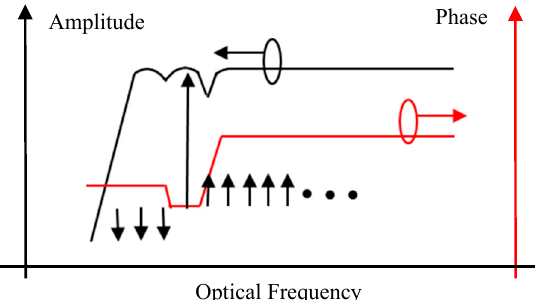
Figure 6. The amplitude and phase response profile of an LCOS based optical processor together with the optical carrier and the RF phase modulation sidebands showing the operation principle of the microwave photonic phase shifter based on LCOS technology.